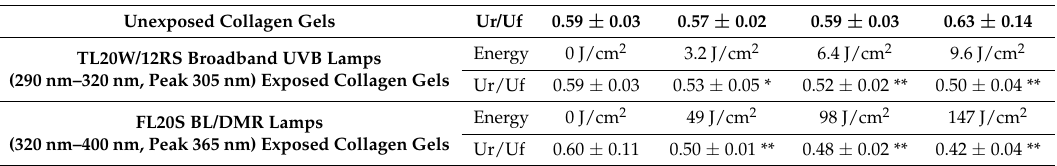
Table 4. Change in elasticity (Ur/Uf) of collagen gels irradiated with either UVB lamps or UVA lamps measured by the Cutometer MPA580.